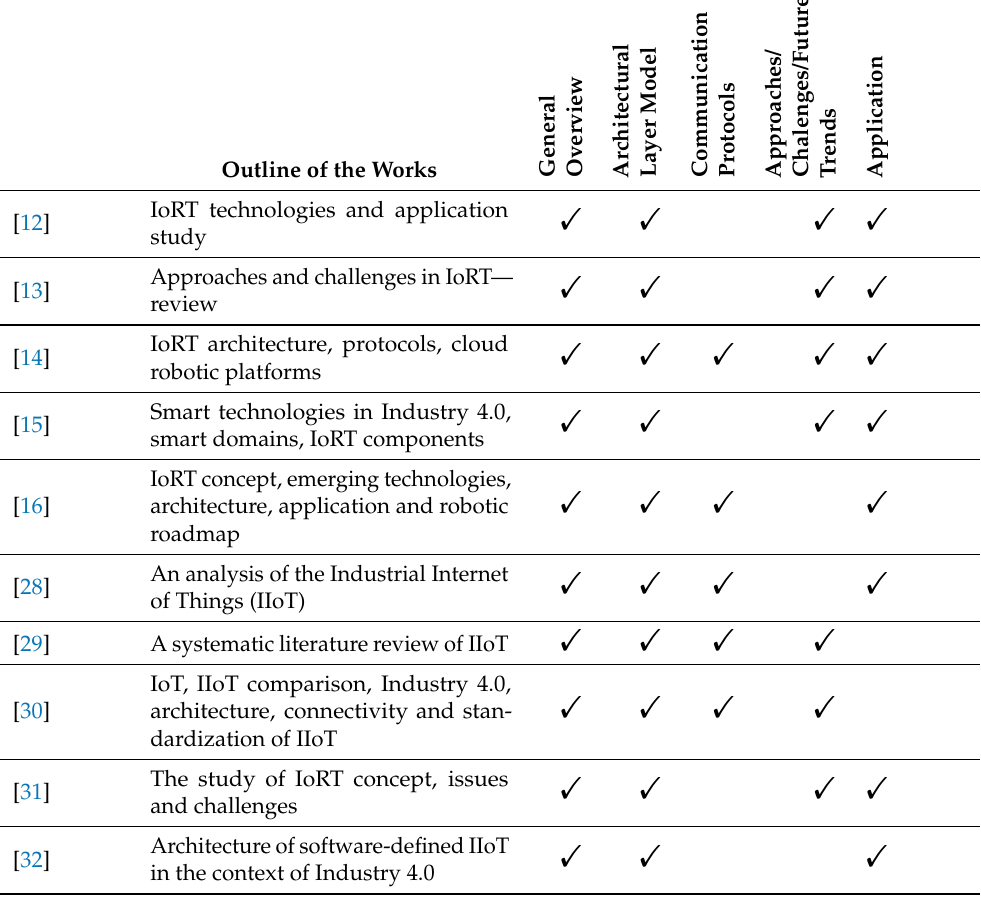
The study of IoRT concept, issues